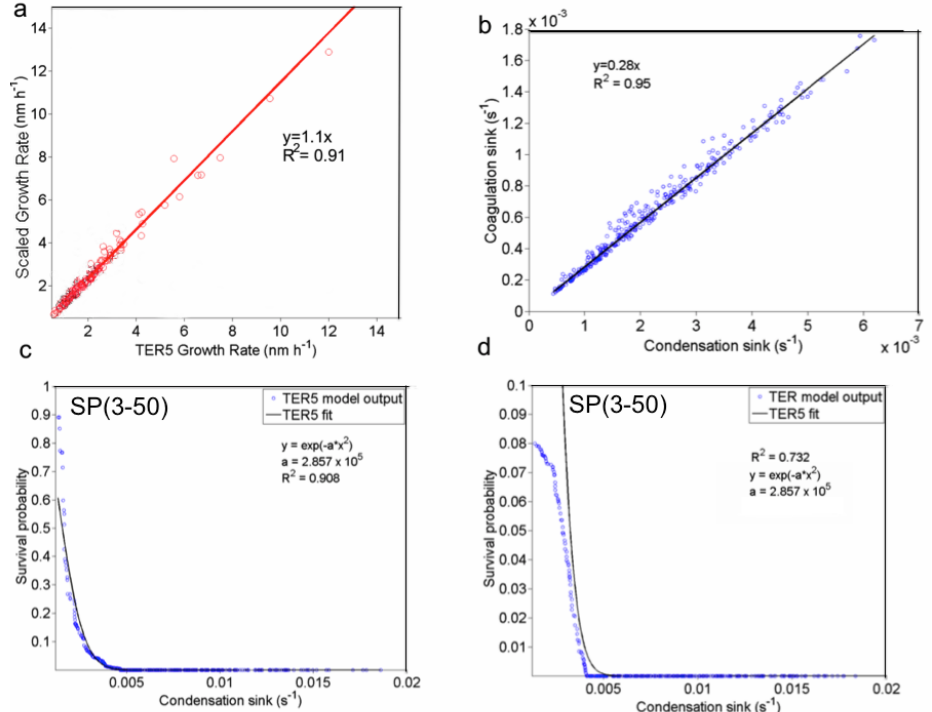
Figure 10. Explanation of the dependence of growth rates and survival probabilities on the condensation sink for one year of nucleation events at Hyytiälä. Panel (a) shows scaled TER vs. TER5 growth rates (red circles). The ternary growth rates have been scaled by the ratio of the two nucleation mechanisms’ condensation sinks. Solid red line represents the line of best fit ( y = 1.1 x , r 2 = 0.91). Panel (b) shows the correlation between coagulation sink and condensation sink. Solid blue line is best fit ( y = 0.28 x , r 2 = 0.95). Panel (c) shows the plot of survival probability (to 50nm) vs. condensation sink for the TER5 simulations (blue circles). Solid black line represents a model fit to the TER5 data of the form y = exp( − a · x 2 ) as described in the text. Value of a is given in the figure. Panel (d) is the same as (c) , except that the TER model output (blue circles) is compared to the same TER5 fit from panel (c) (same equation and